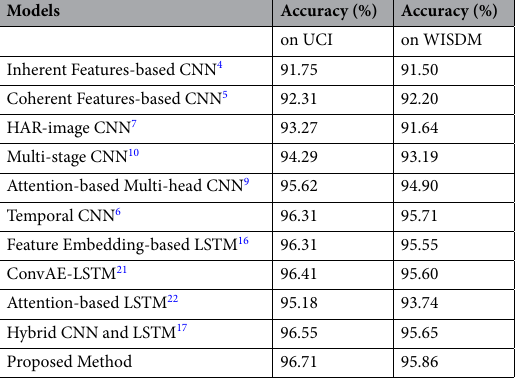
Table 2. The classification comparation on the UCI and WISDM datasets.